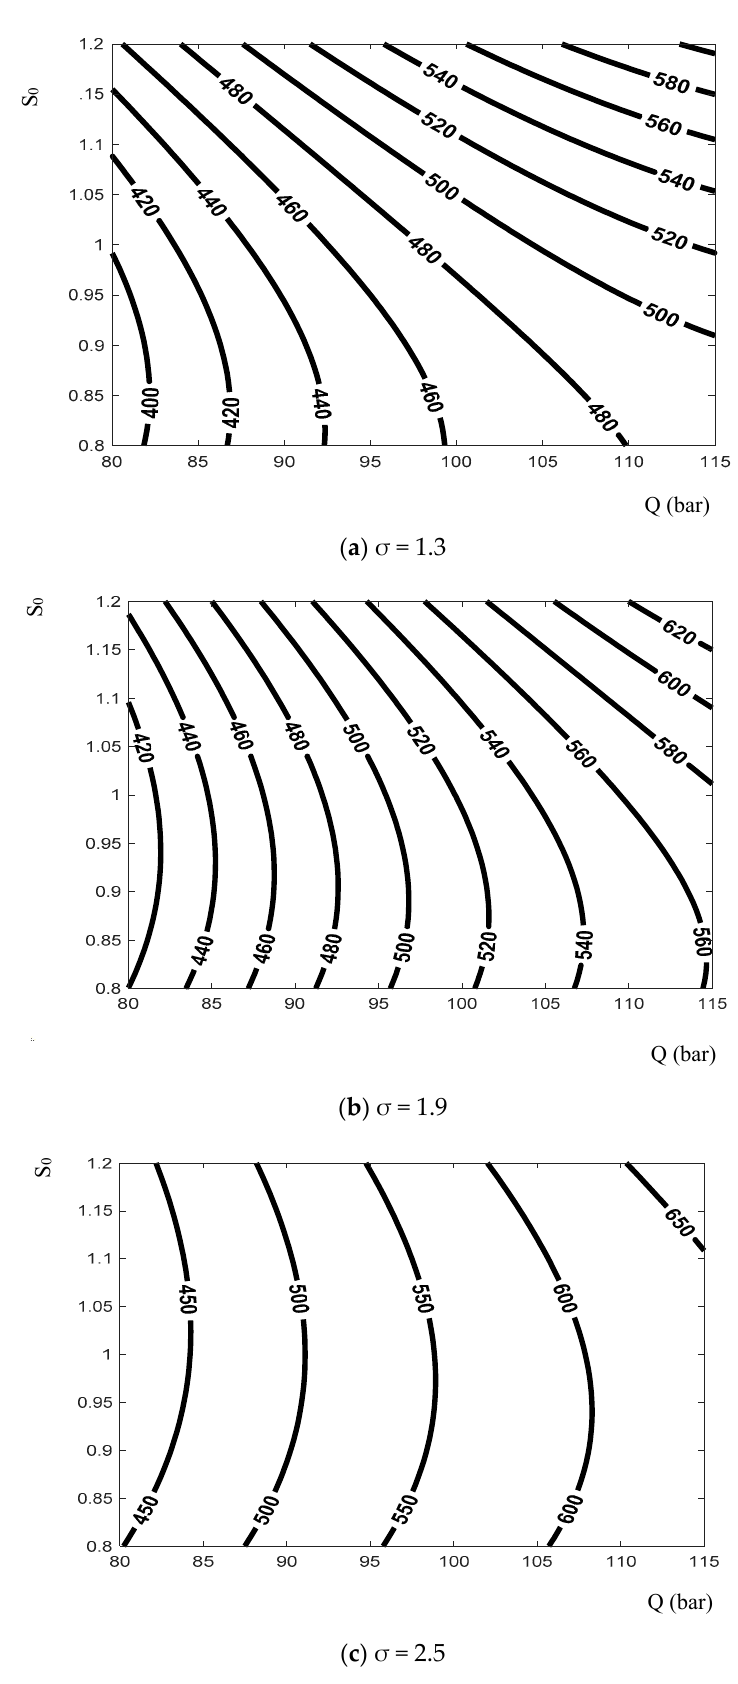
Figure 12. Dependence of the maximum forming pressure on the binder pressure and the thickness.